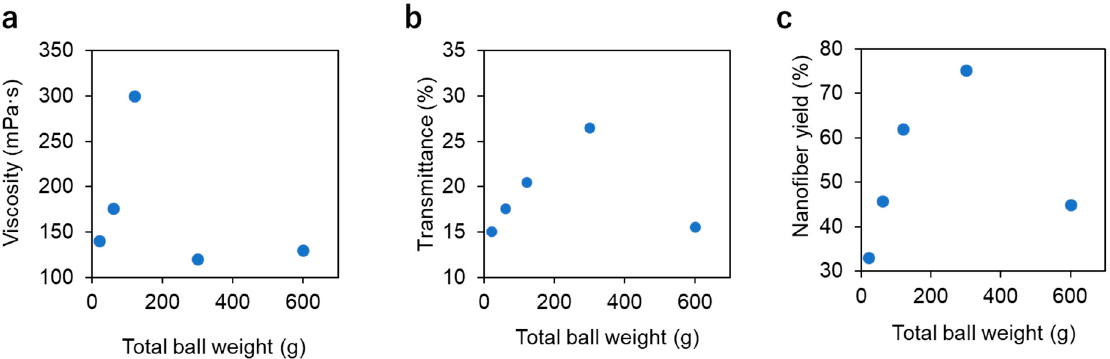
Figure 4. ( a ) Viscosity, ( b ) transmittance at 600 nm, and ( c ) nanofiber yield after milling of chitin using different total ball weights.